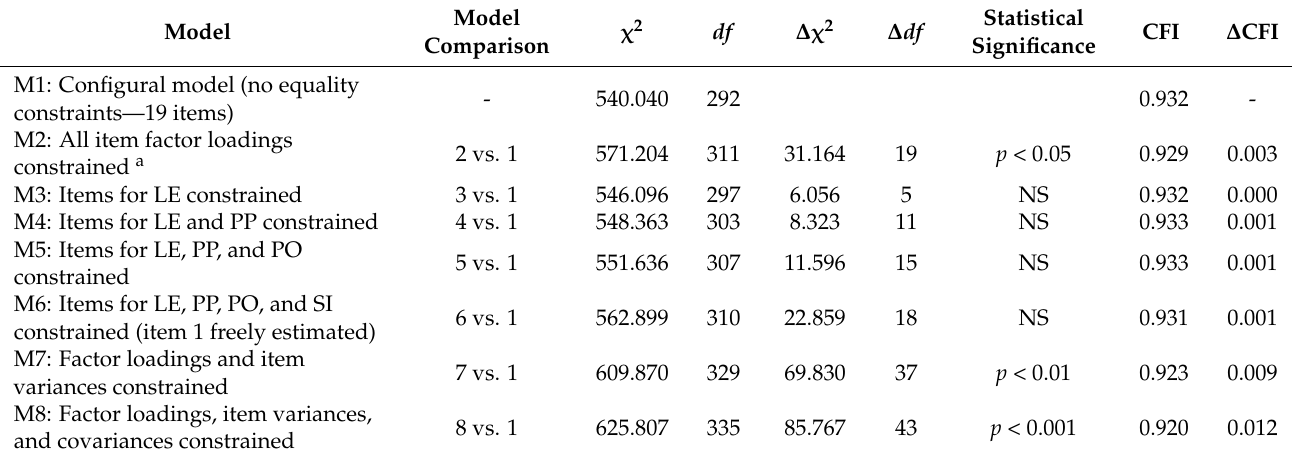
Table 8. Summary of fit statistics for tests of gender